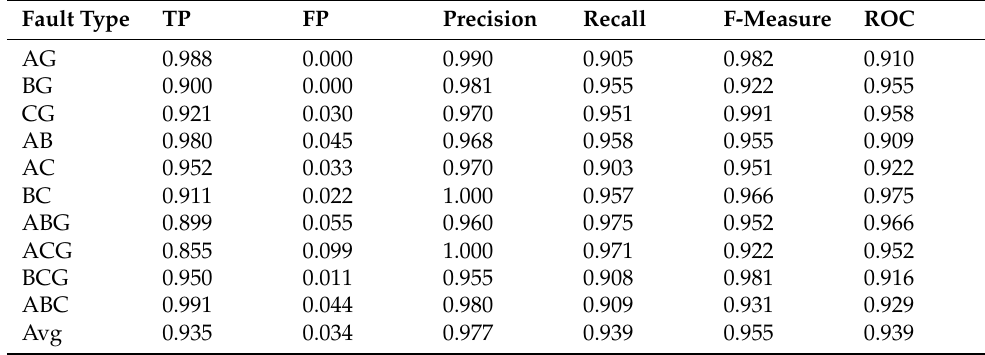
Table 15. SVM classification from half a cycle post-fault with PV and WE sources.